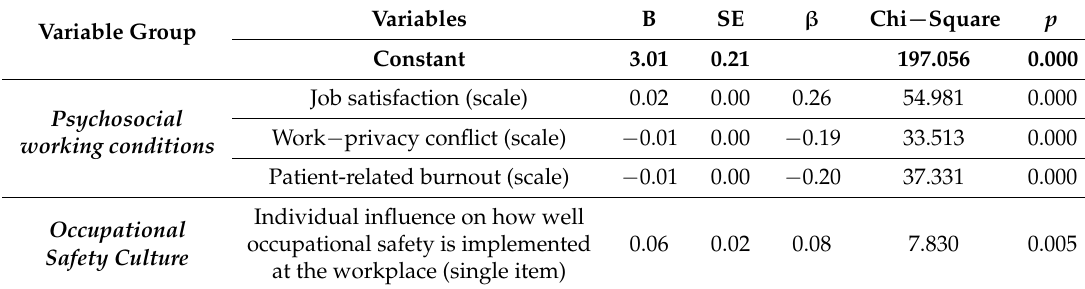
Table 5. Occupational Safety Culture model—stepwise linear regression analysis adjusted for cluster